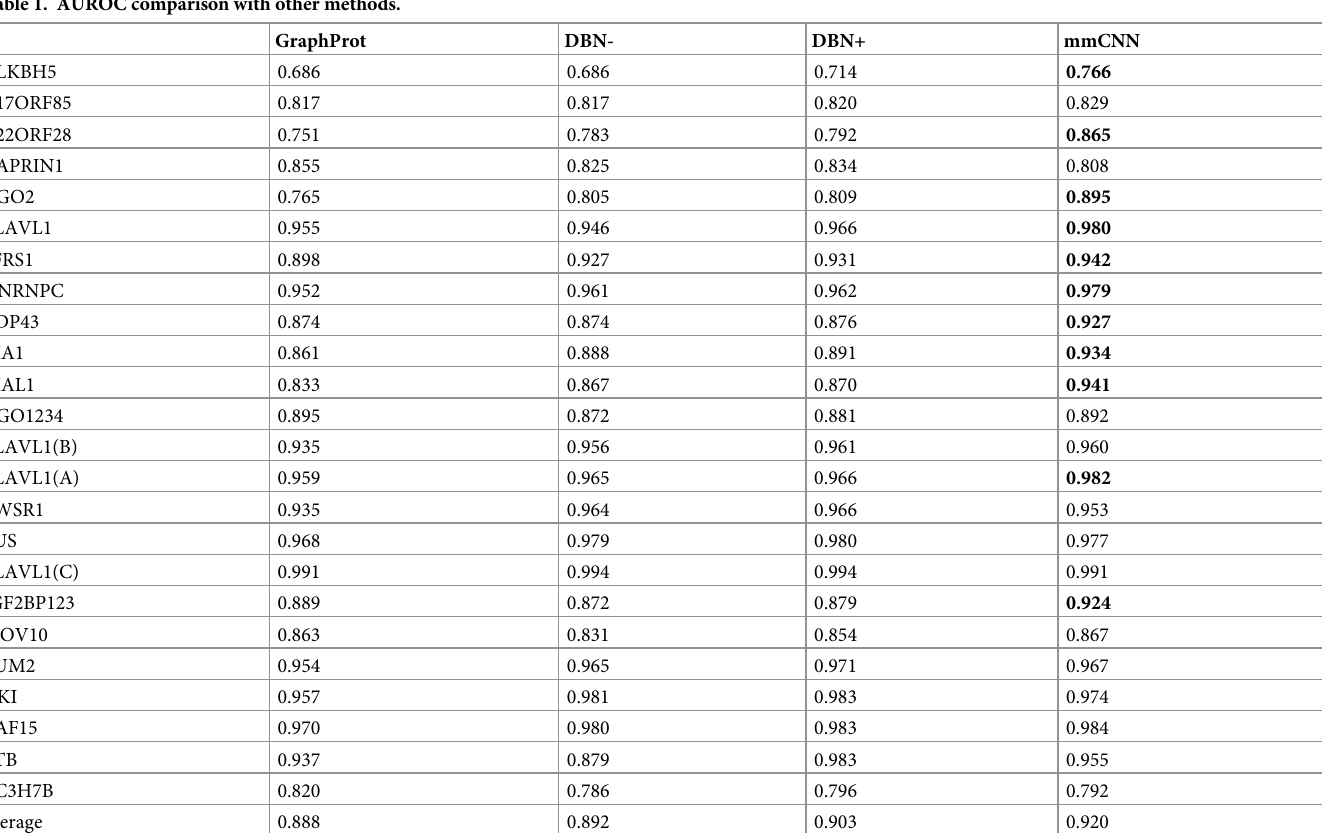
Table 1. AUROC comparison with other